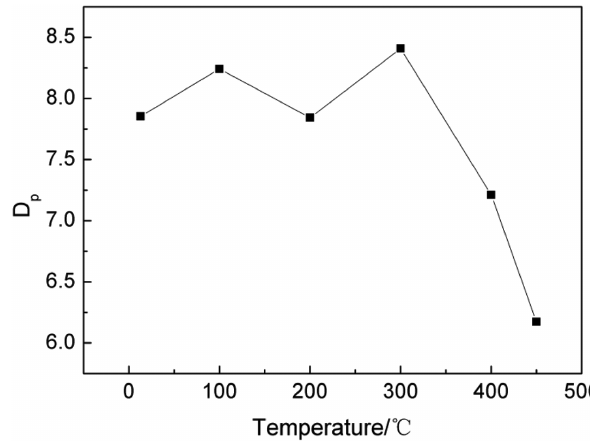
Figure 8: The variation of penetration depth of the CuCl residue with